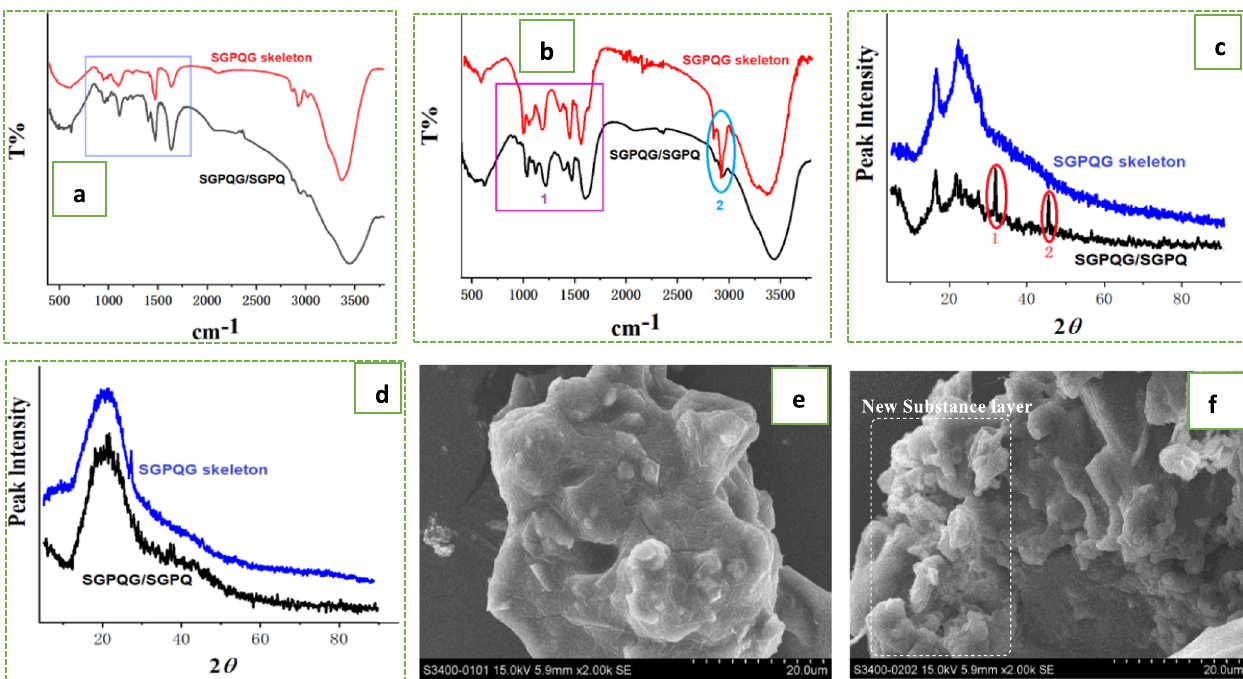
Fig. 4 Micro-structure transformations of SGPQG/SGPQ treatment with lignins. a FT-IR analysis of SGPQG/SGPQ material and SGPQG skeleton component. b FT-IR analysis of SGPQG/SGPQ material and SGPQG skeleton component after treating lignin. c XRD analysis of SGPQG/SGPQ material and SGPQG skeleton component. d XRD analysis of SGPQG/SGPQ material and SGPQG skeleton component after treating lignin. SEM analysis of SGPQG/SGPQ material before ( e ) and after (f ) treating